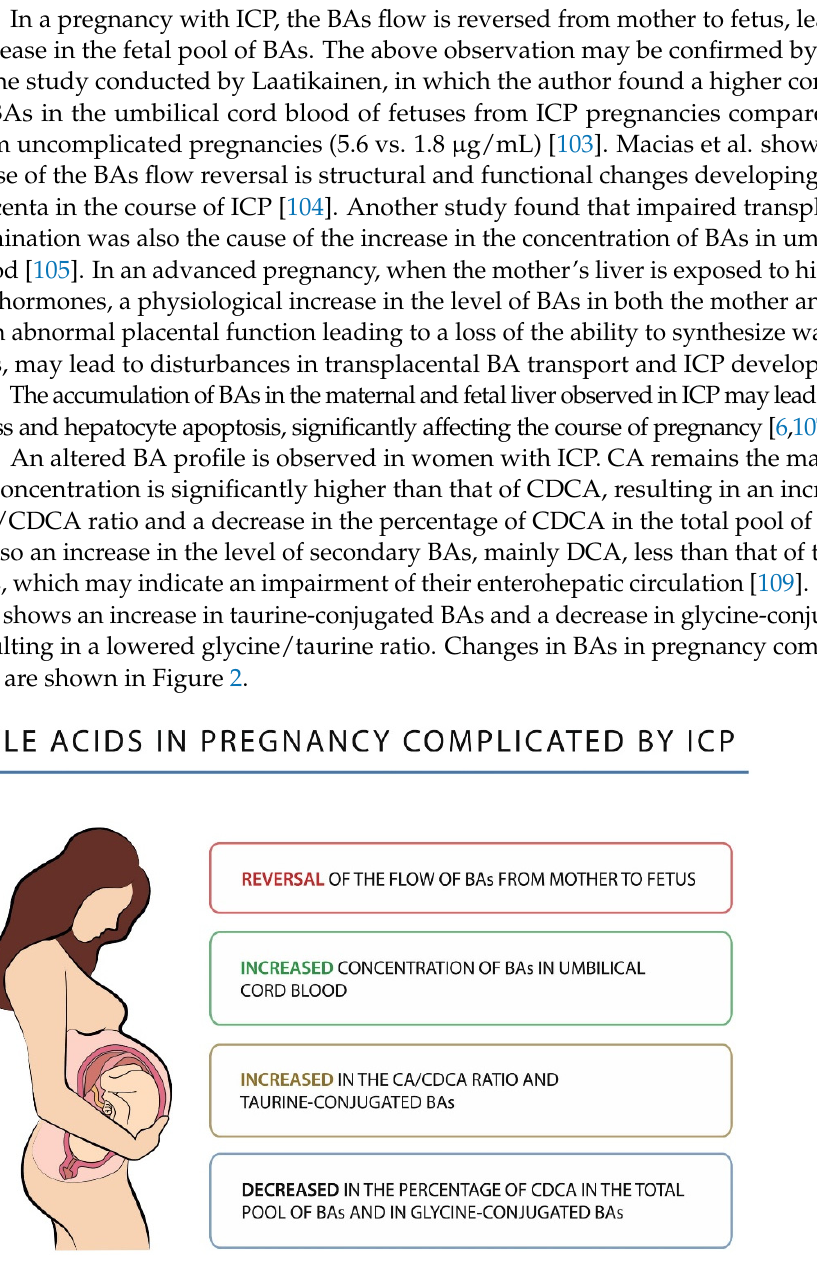
Figure 2. Bile acids in pregnancy complicated by ICP.